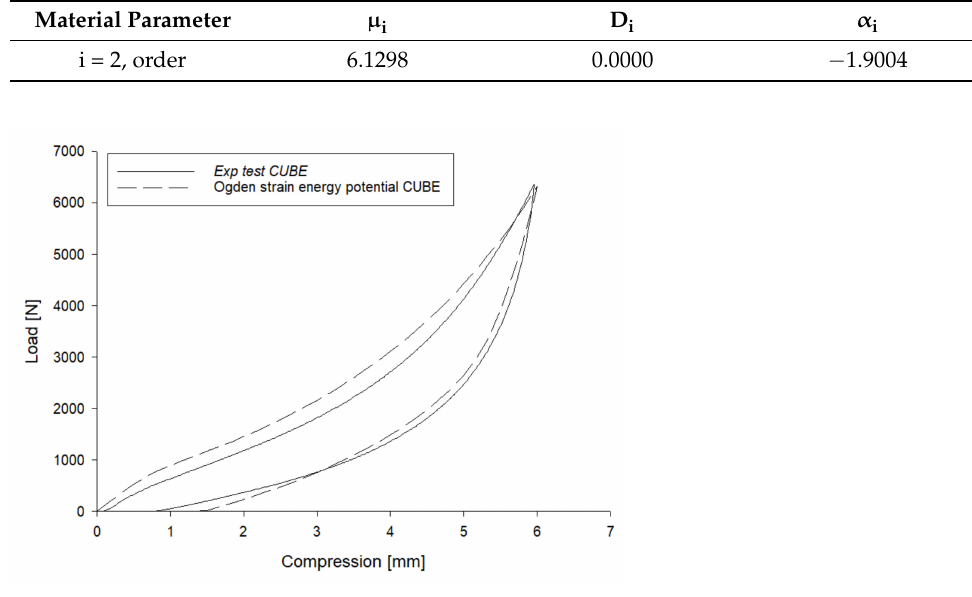
Figure 7. Determination of the hysteresis cycle. Table 3. Abaqus hysteresis